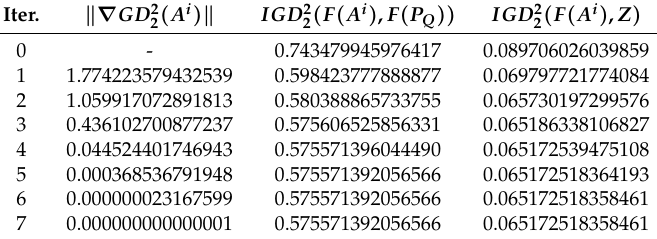
-Newton method for BOP (51), see Figure 10. 2